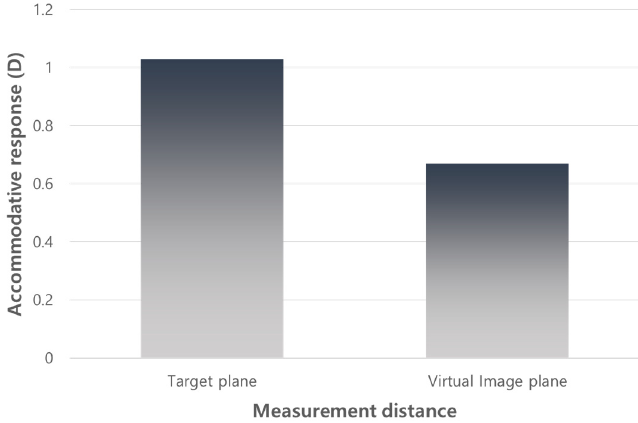
Figure 10. Comparison of accommodative response of target (1.00 D) and virtual image planes.